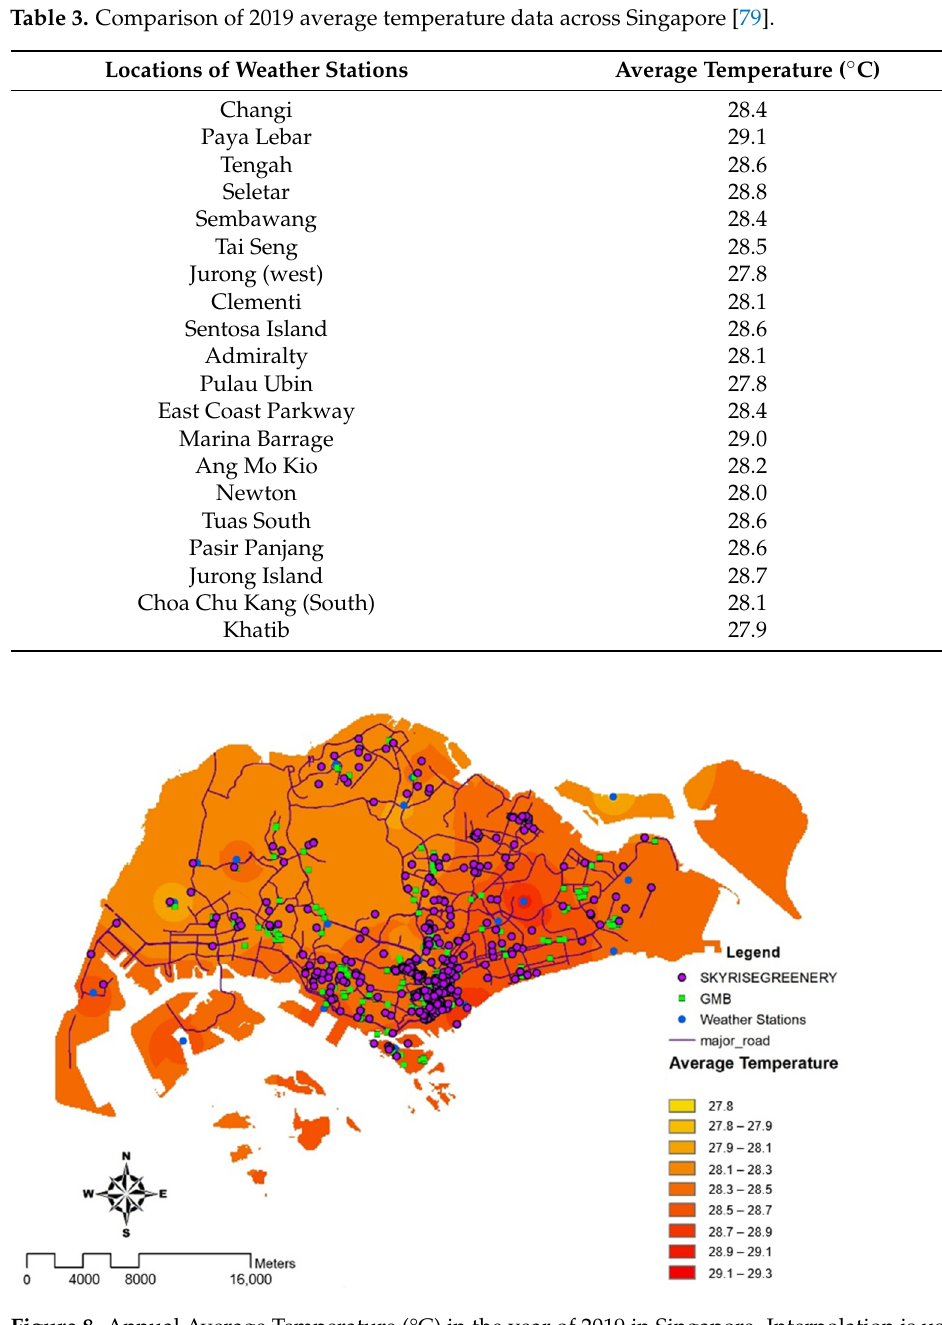
Table 3. Comparison of 2019 average temperature data across Singapore [79].